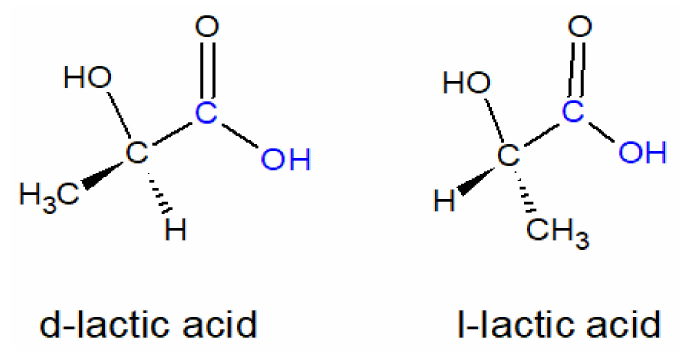
Figure 2. Lactic acid stereoisomers